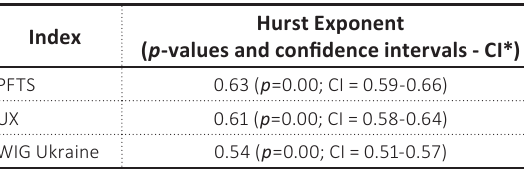
Table 6. Static R/S analysis results